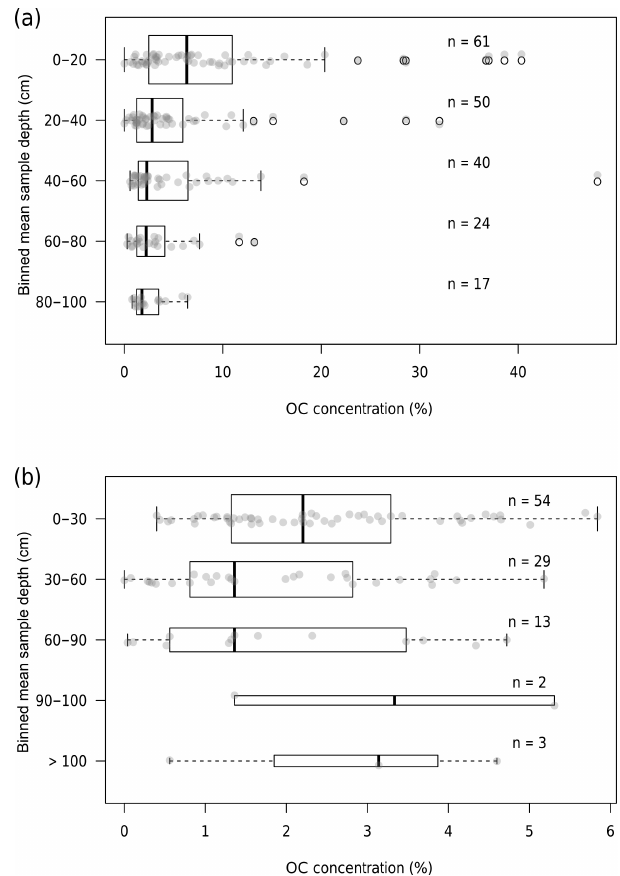
Figure 3. Box plots of sample OC concentration binned by mean sample depth for the wet (a) and semiarid (b) basins. Ends of dot- ted lines represent 1.5 times the interquartile range, which is rep- resented by boxes. Bold line represents median. Black circles rep- resent outliers. Transparent grey points show all data for each bin. Sample size for each bin is denoted by n